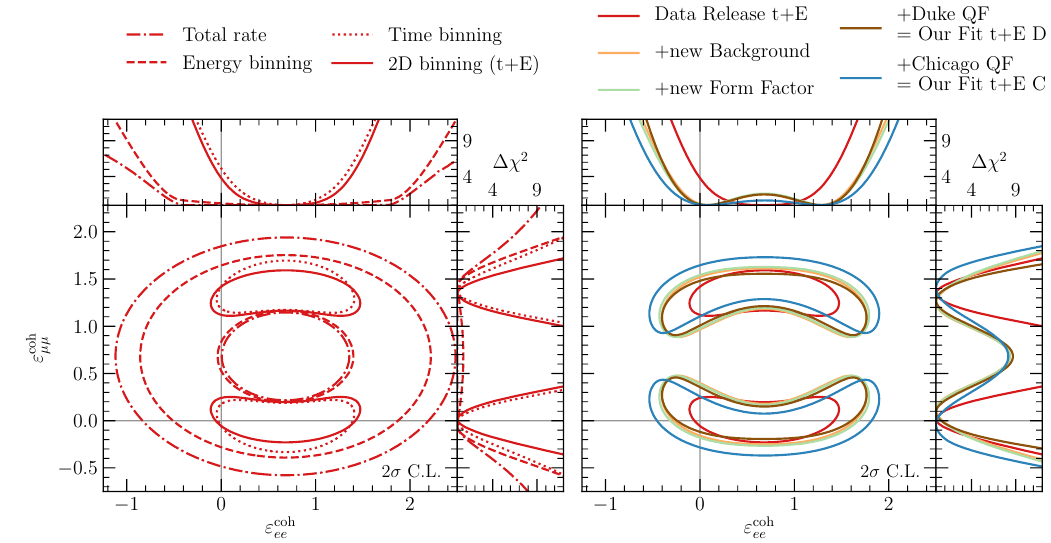
Figure 7 . 2 (cid:27) allowed regions for the (cid:13)avor-diagonal NSI coe(cid:14)cients " coh (assuming zero non- (cid:11)(cid:12) diagonal couplings) for a variety of (cid:12)ts to COHERENT data as labeled in the (cid:12)gure. In all cases shown in the left panel, the QF, nuclear FF and background assumptions are those employed in the data release [36]. On the right panel we show the dependence on the assumptions for steady background modeling, nuclear FF, and QF. For simplicity, in this (cid:12)gure we set all o(cid:11)-diagonal NSI parameters to zero, but it should be kept in mind that the results of our global analysis presented in section 4.2 have been obtained allowing all operators simultaneously in the